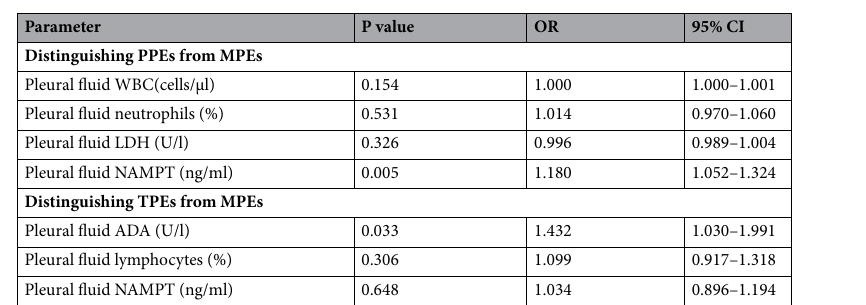
Table 2. Multivariate logistic regression analysis for distinguishing PPEs or TPEs from MPEs. PPE parapneumonic effusion, TPE tuberculous pleural effusion, MPE malignant pleural effusion, WBC white blood cell count, LDH lactate dehydrogenase, NAMPT nicotinamide phosphoribosyltransferase, ADA adenosine deaminase, OR odds ratio, CI confidence